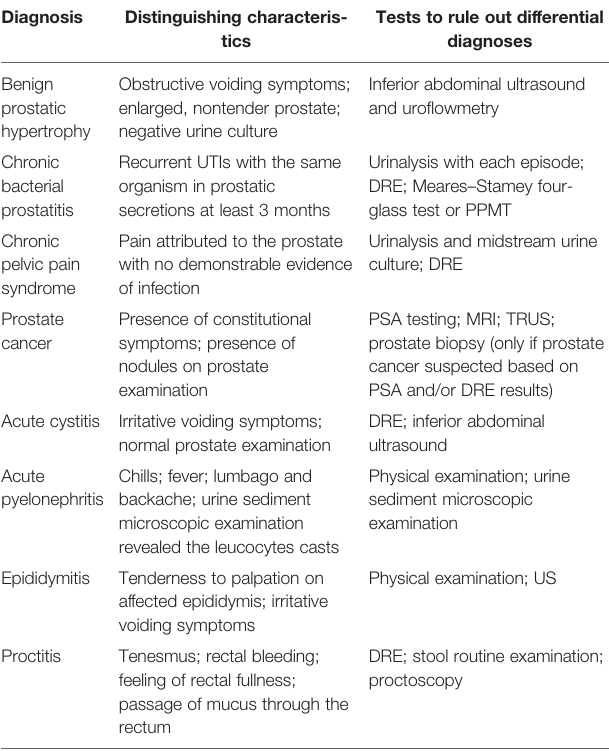
TABLE 1 | Differential Diagnosis of Acute Bacterial